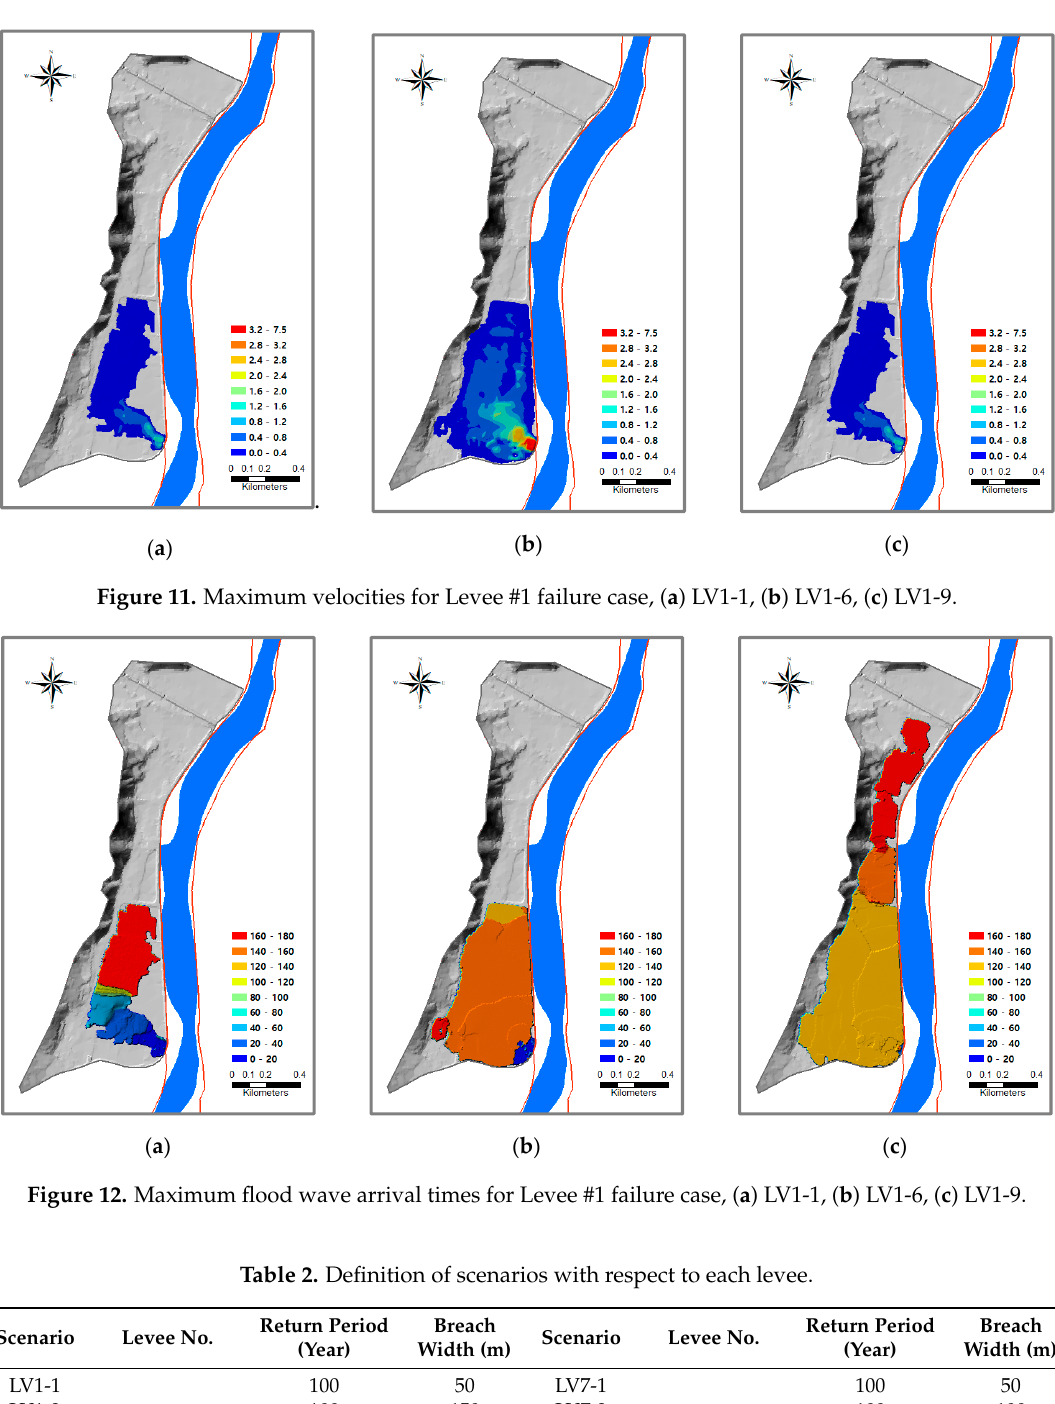
Figure 10. Maximum flood depths for Levee #1 failure case, ( a ) LV1-1, ( b ) LV1-6, ( c ) LV1-9.